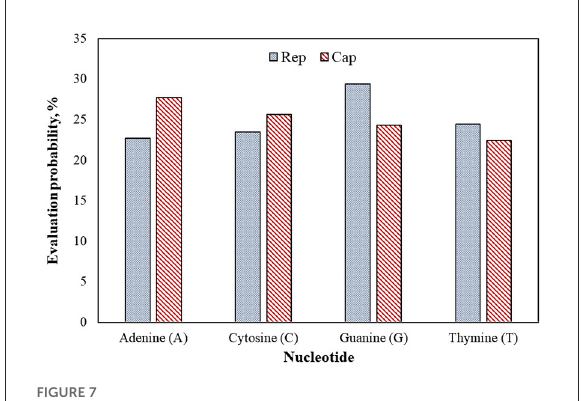
FIGURE7 Evolutionary probability of rep and cap nucleotides from the database used in phylogenetic analysis, including 43 rep and 36 cap sequences. Mega ver. 11 was used for this analysis based on Tamura-Nei model and Bayesian/Realtime statistical method. All codon positions were considered in this analysis.